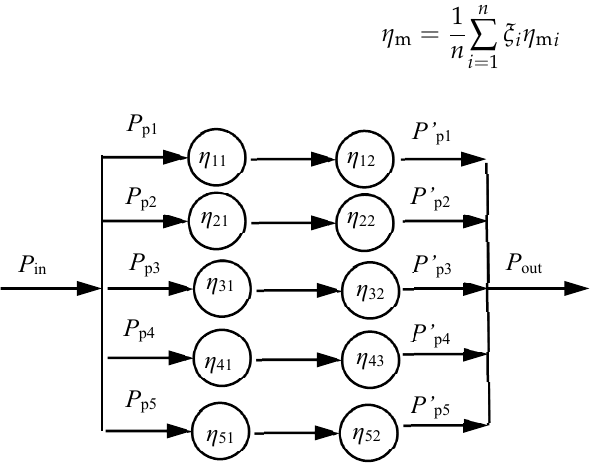
Figure 3. Power splitting diagram of the star gear train.